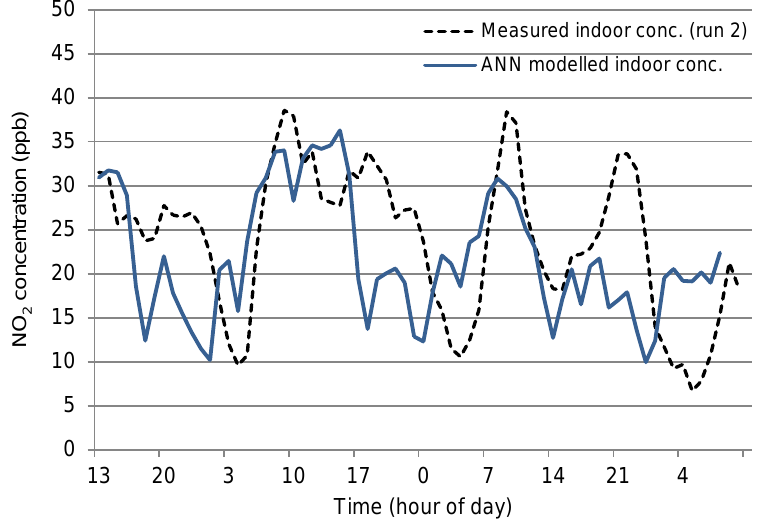
Figure 6. Measured versus modelled NO 2 concentrations at M c 2.